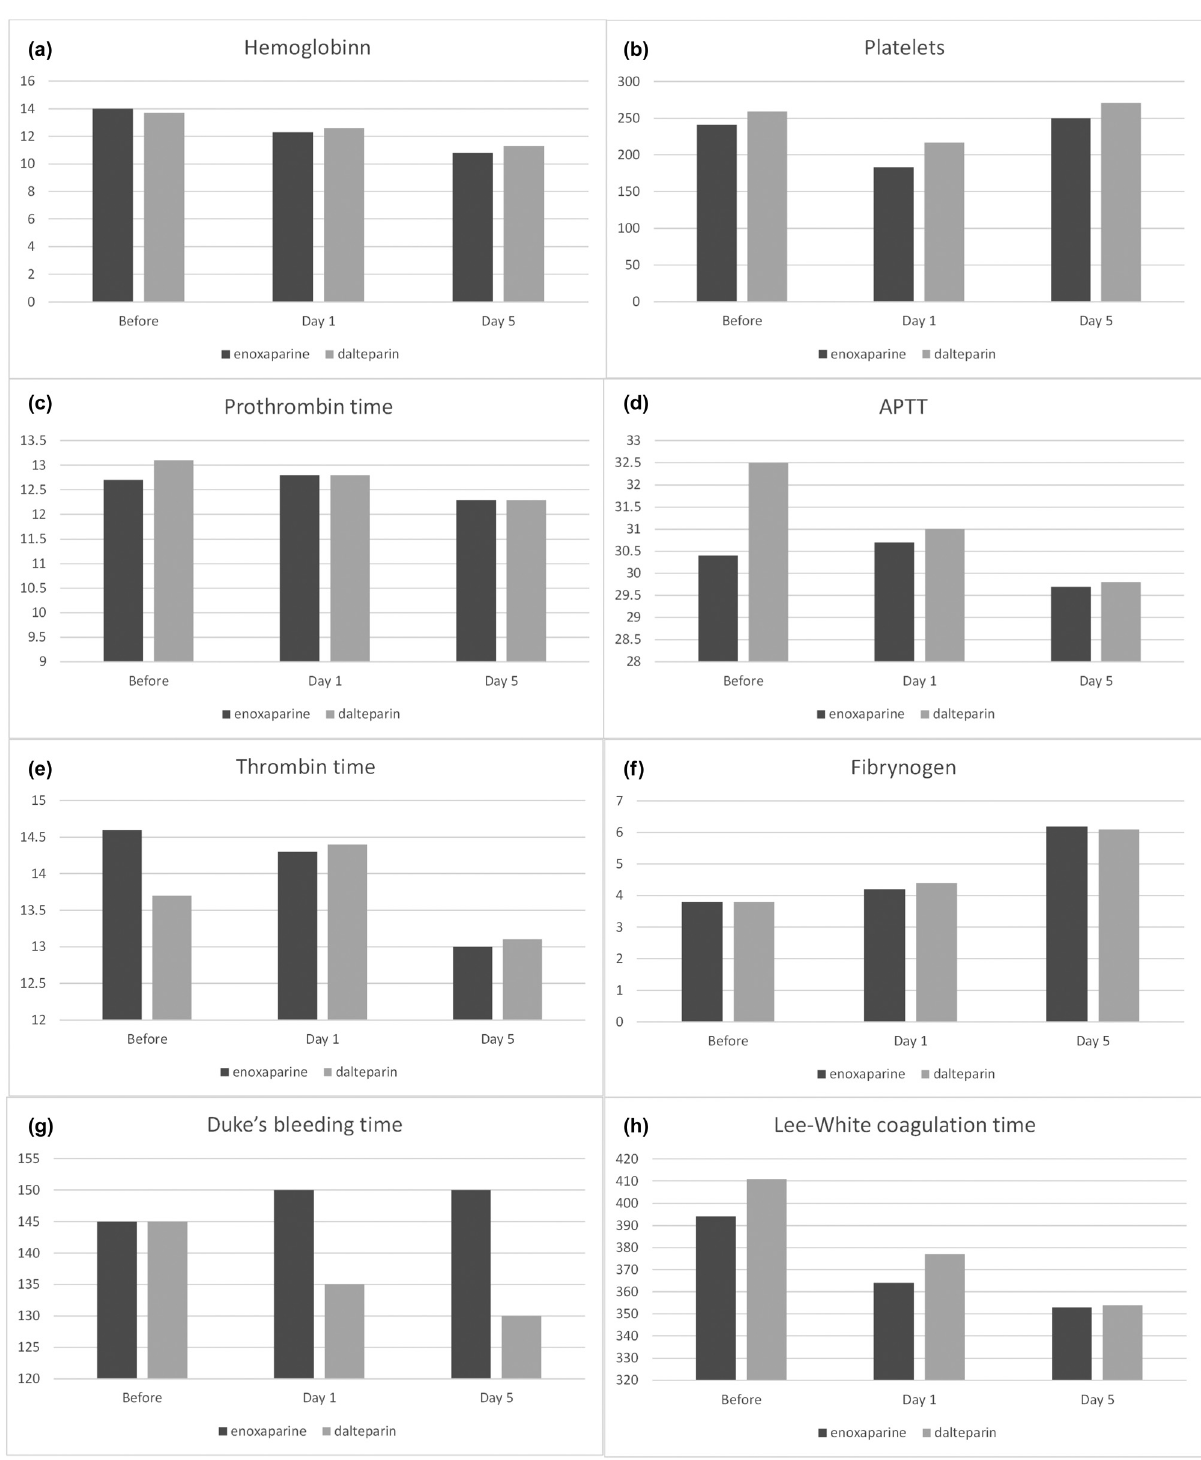
Figure 1: Comparison of the blood results among the study